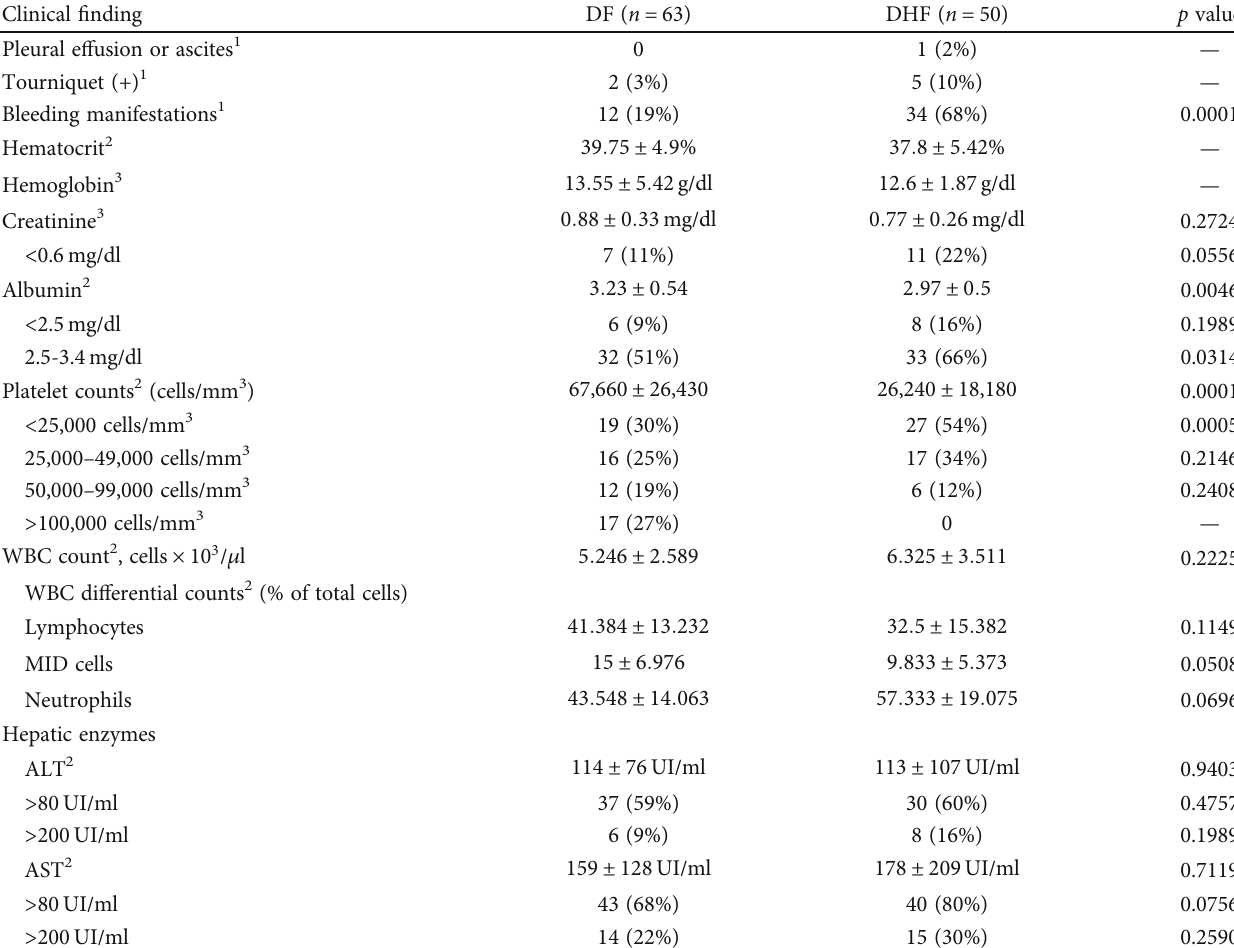
Table 2: Clinical and laboratory features of patients with dengue fever (DF) and dengue hemorrhagic fever (DHF). Clinical fi